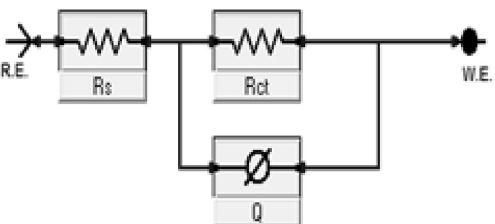
Figure 14. Schematic for the equivalent circuit models used to determine the impedance Parameters for scale process in the CaCl 2 brine solution. (R s ; the solution resistance, R ct ; the charge transfer resistance, Q; is associated to the double-layer